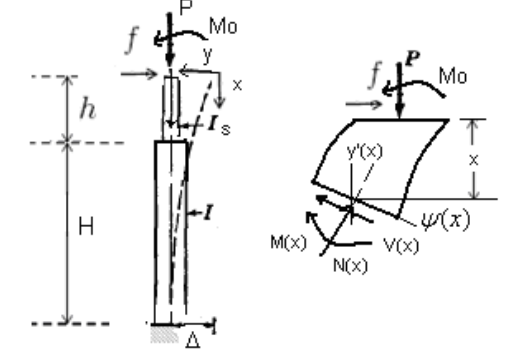
Fig.1 Independent column in series with the isolation bearing